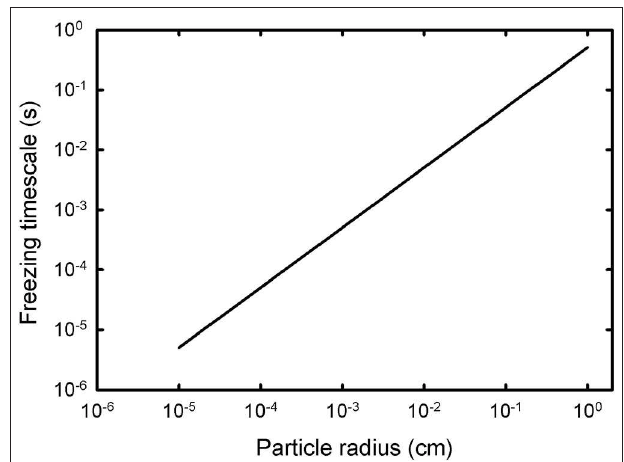
FIGURE 1 | The time required to completely freeze a pure liquid water droplet at 273K by cooling from evaporation, balancing the mass lost from Equation (ii) with the evaporation rate from Equation (v).